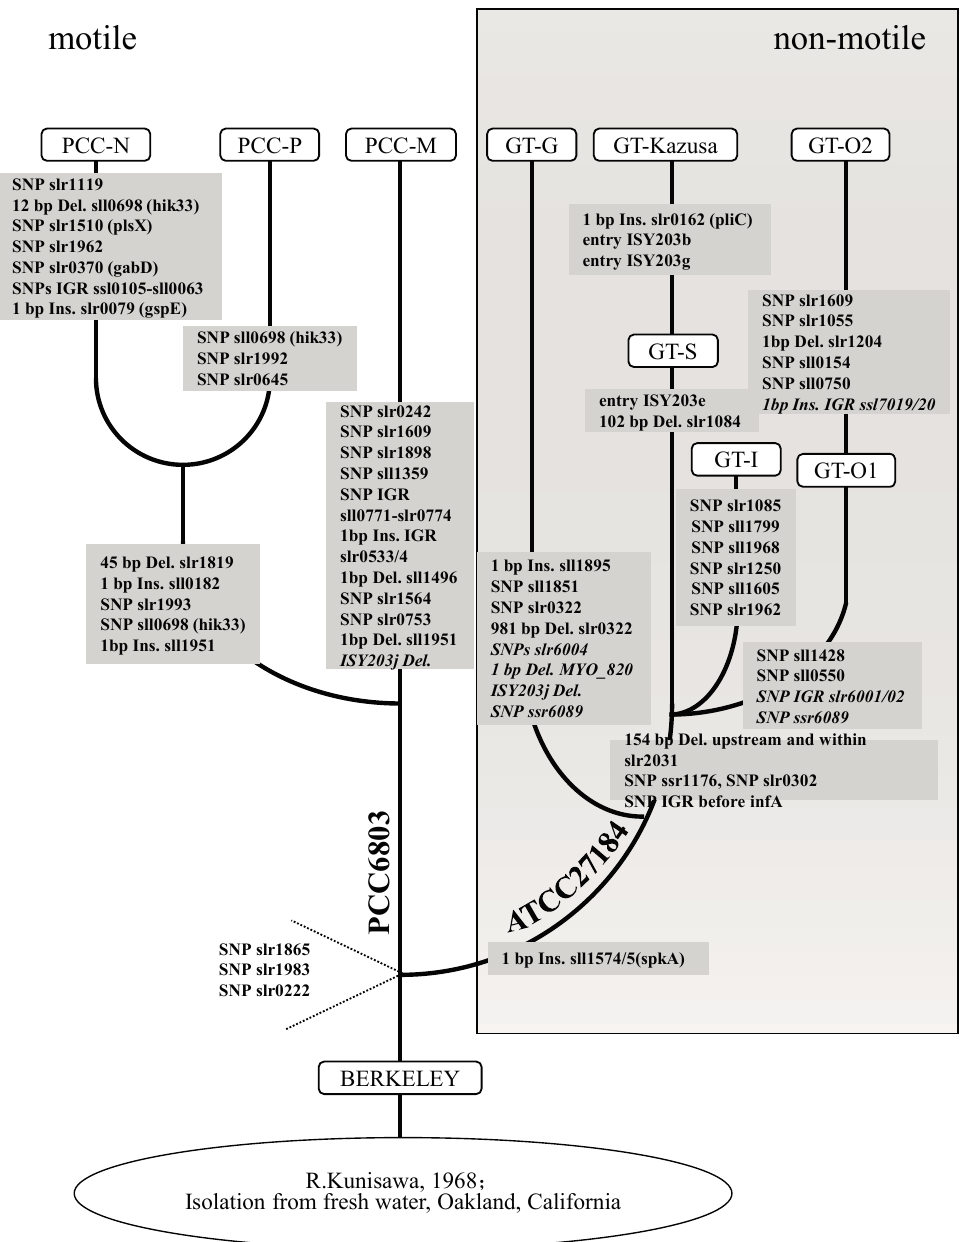
Figure 3. Visualization of phylogenetic relationships among various sequenced stains of Synechocystis sp. PCC 6803. The presence of identified SNPs and indels are indicated along the branches. The variants in plasmid are in italic. Putative insertions, deletions, and intergenic regions are labeled as Ins, Del, and IGR respectively. Modified